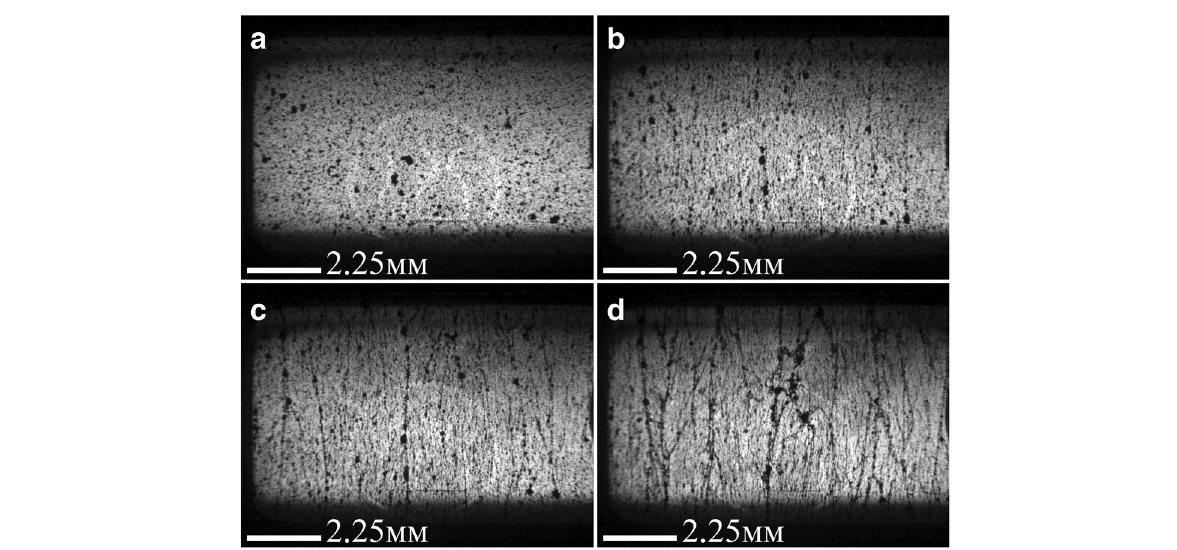
Fig. 4 Optical images of 0.05 wt% MWCNTs/Larit 285 composite under AC electric field action (frequency of 15 kHz, strength of 50 kV/m) (embedded electrodes): а — before electric field action; b — after 12 min; c — after 26 min; d — after 60 min of electric field action. Image size 10.8 × 8.0 mm 2